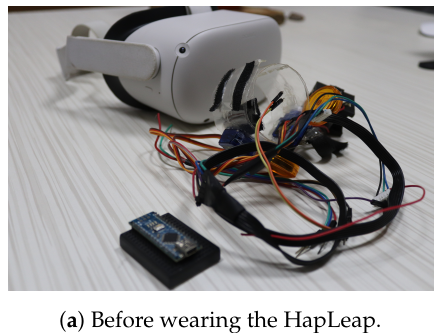
Figure 6. HapLeap interactive